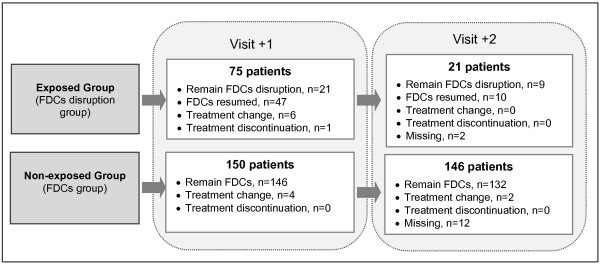
Flow of exposed and non-exposed patients during visits +1 and +2.